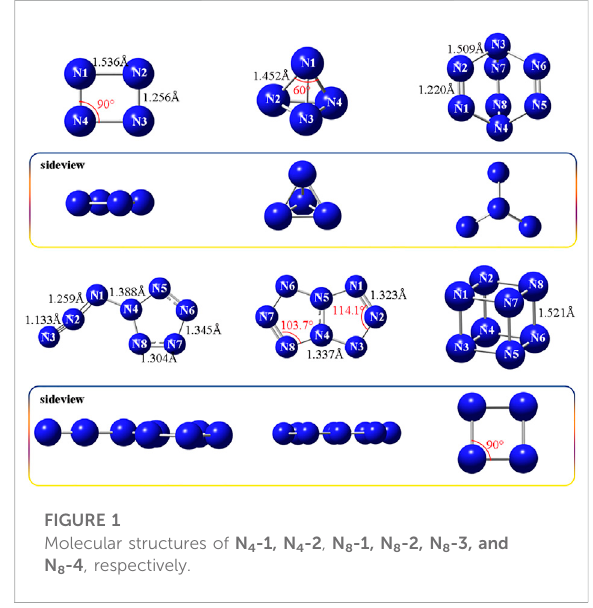
FIGURE 1 Molecular structures of N 4 -1, N 4 -2 , N 8 -1, N 8 -2, N 8 -3, and N 8 -4 ,